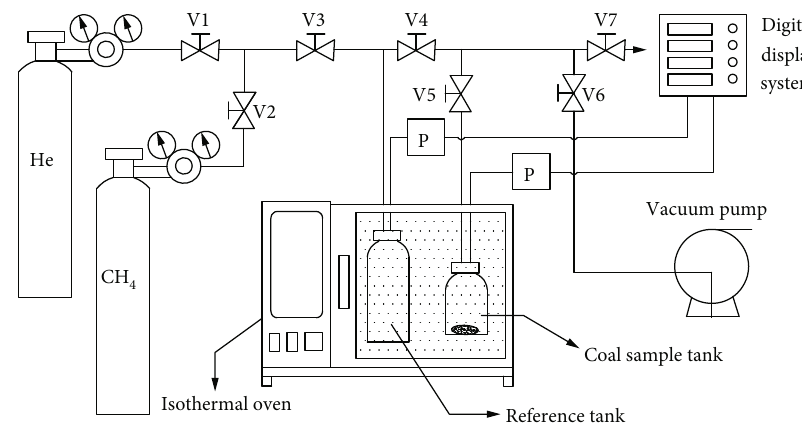
Figure 2: Experiment system schematic